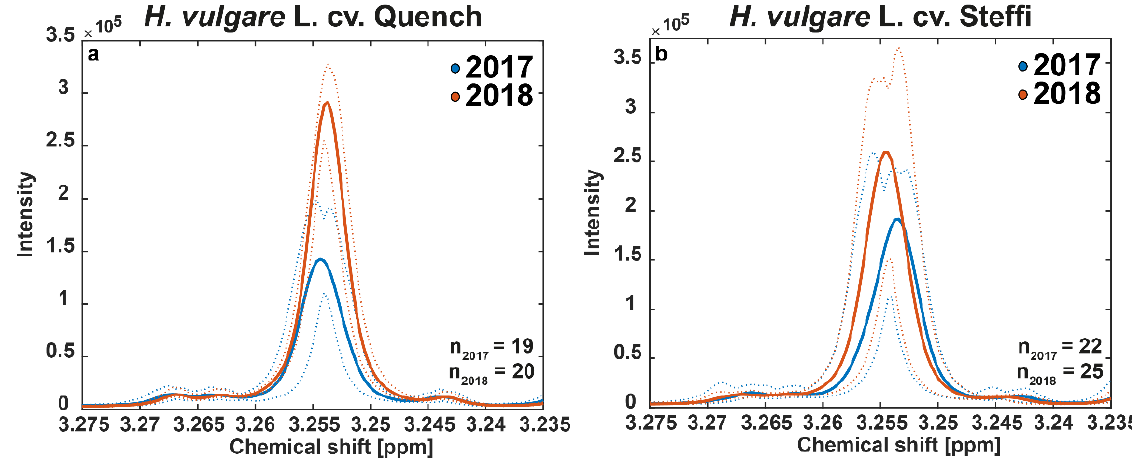
Figure 6. Comparison of the content of the plant-physiological marker betaine. Plots show the 1 H-NMR spectra region (3.275–3.235 ppm), including the signal of betaine at 3.255 ppm chemical shift. The two spring barley varieties ( a ) Quench and ( b ) Steffi were analyzed as wholemeal flour extracts. Average spectra are displayed as solid lines and the 95% confidence intervals are represented as dotted lines. Samples are colored by the harvest years 2017 (blue) and 2018 (red). Note that there are minor differences in chemical shift due to slight variations in the sample conditions, which lead to apparent multiplets when the included spectra are averaged. This also creates multiple maxima for the confidence intervals (dotted lines). However, the betaine signal at 3.255 ppm is a singlet.